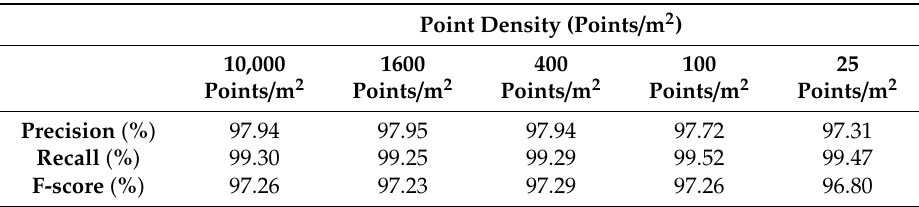
Table 20. The results of quality analysis of building outline extraction for different point cloud densities (1 cm, 2.5 cm, 5 cm, 10 cm, 20 cm) for a direct approach.